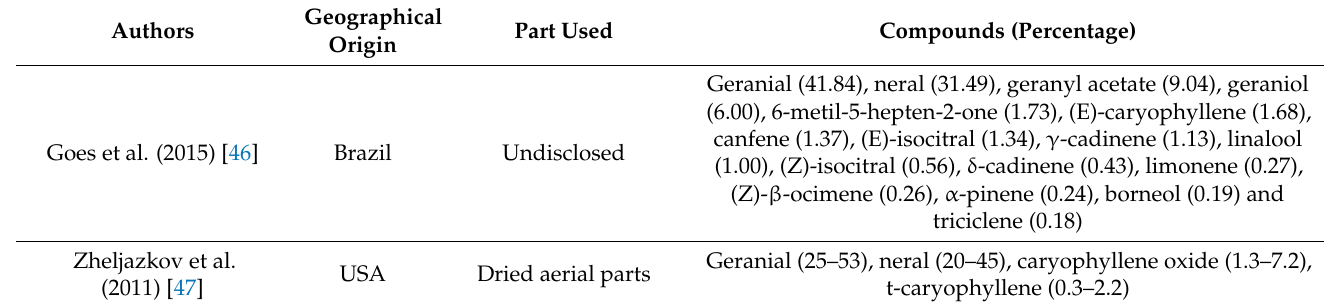
Table 1. Composition of lemongrass essential oils from different geographical